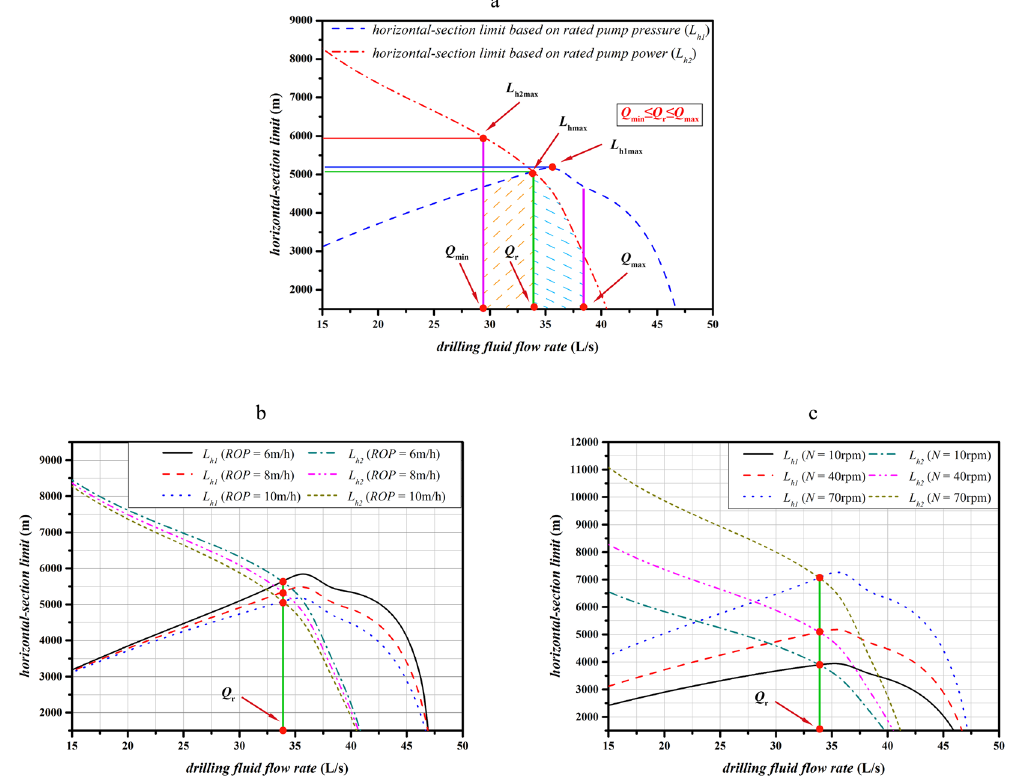
Figure 2. Effects of drilling fluid flow rate on L h1 and L h2 & the schematic overview of the situation Q min ≤ Q r ≤ Q max (Case I). ( a ) Effects of drilling fluid flow rate on L h1 and L h2 ; ( b ) Effects of different ROPs on L h1 and L h2 ; ( c ) Effects of different drill pipe rotation speeds on L h1 and L h2 .